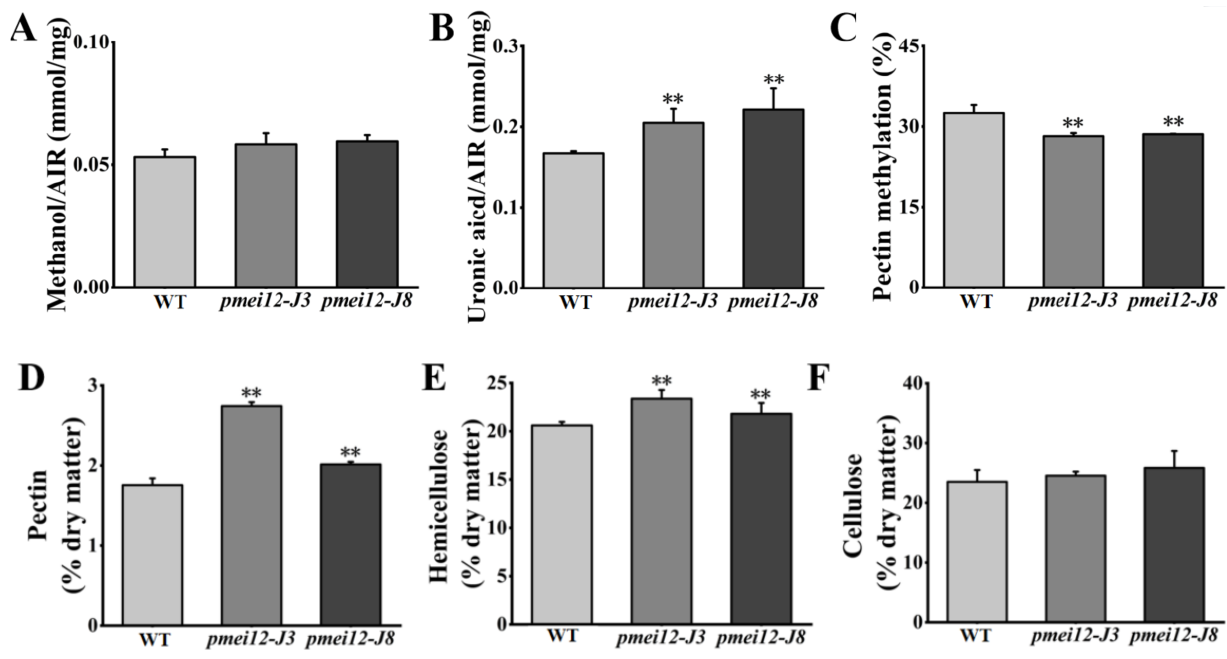
Figure 7. Cell wall composition of pmei12 lines and WT at seedling stage. ( A ) Methanol (AIR); ( B ) Uronic acid (AIR); ( C ) Pectin methylation (%); ( D ) Pectin content dry matter; ( E ) Hemicellulose content dry matter; ( F ) Cellulose content dry matter. ** indicate the significant differences between pmei12 lines and WT by t -test at p < 0.01 (n = 3).